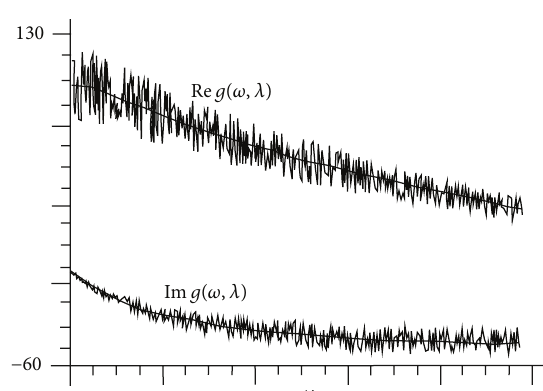
Figure 3: The example of additional information 𝑔(𝜔,𝜆) given with the error 𝑃 = 20 % ( 𝜔 ∈ [𝜔 0 /50, 𝜔 0 /10] , 𝜆 = 5⋅10 −1 ); the exact values of real and imaginary parts of 𝑔(𝜔,𝜆) are shown by the smooth